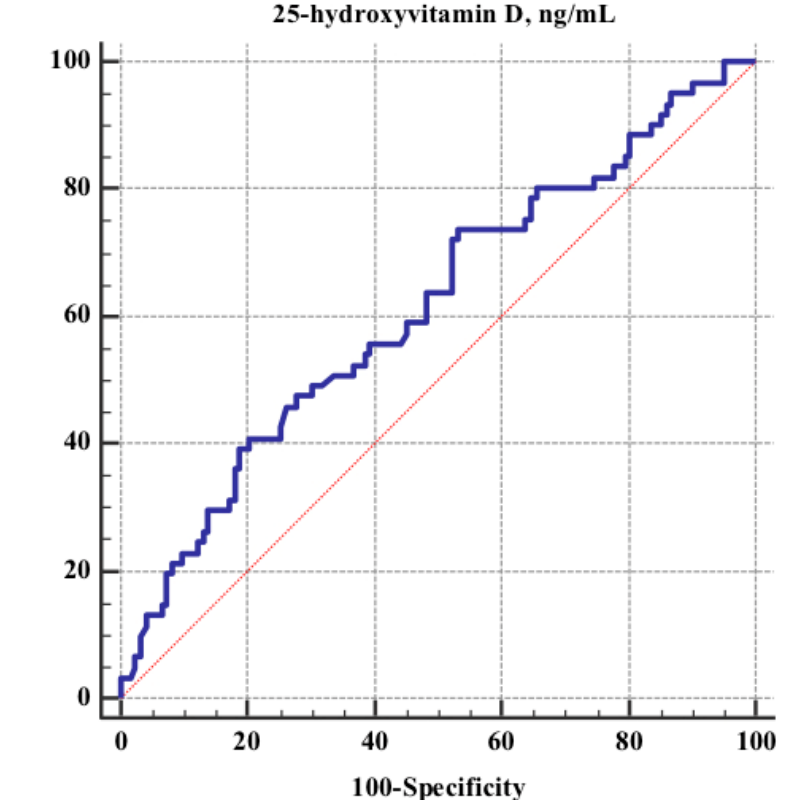
Figure 2. ROC (Receiver Operating Characteristic) curve for discriminative power of vitamin D status respect COV positivity. AUC 0.61 (95% CI 0.6–0.7), p = 0.01; Youden Index 0.21; criterion value corresponding to Youden Index: ≤ 24.4 ng/mL, sensitivity 74%, specificity 47%.